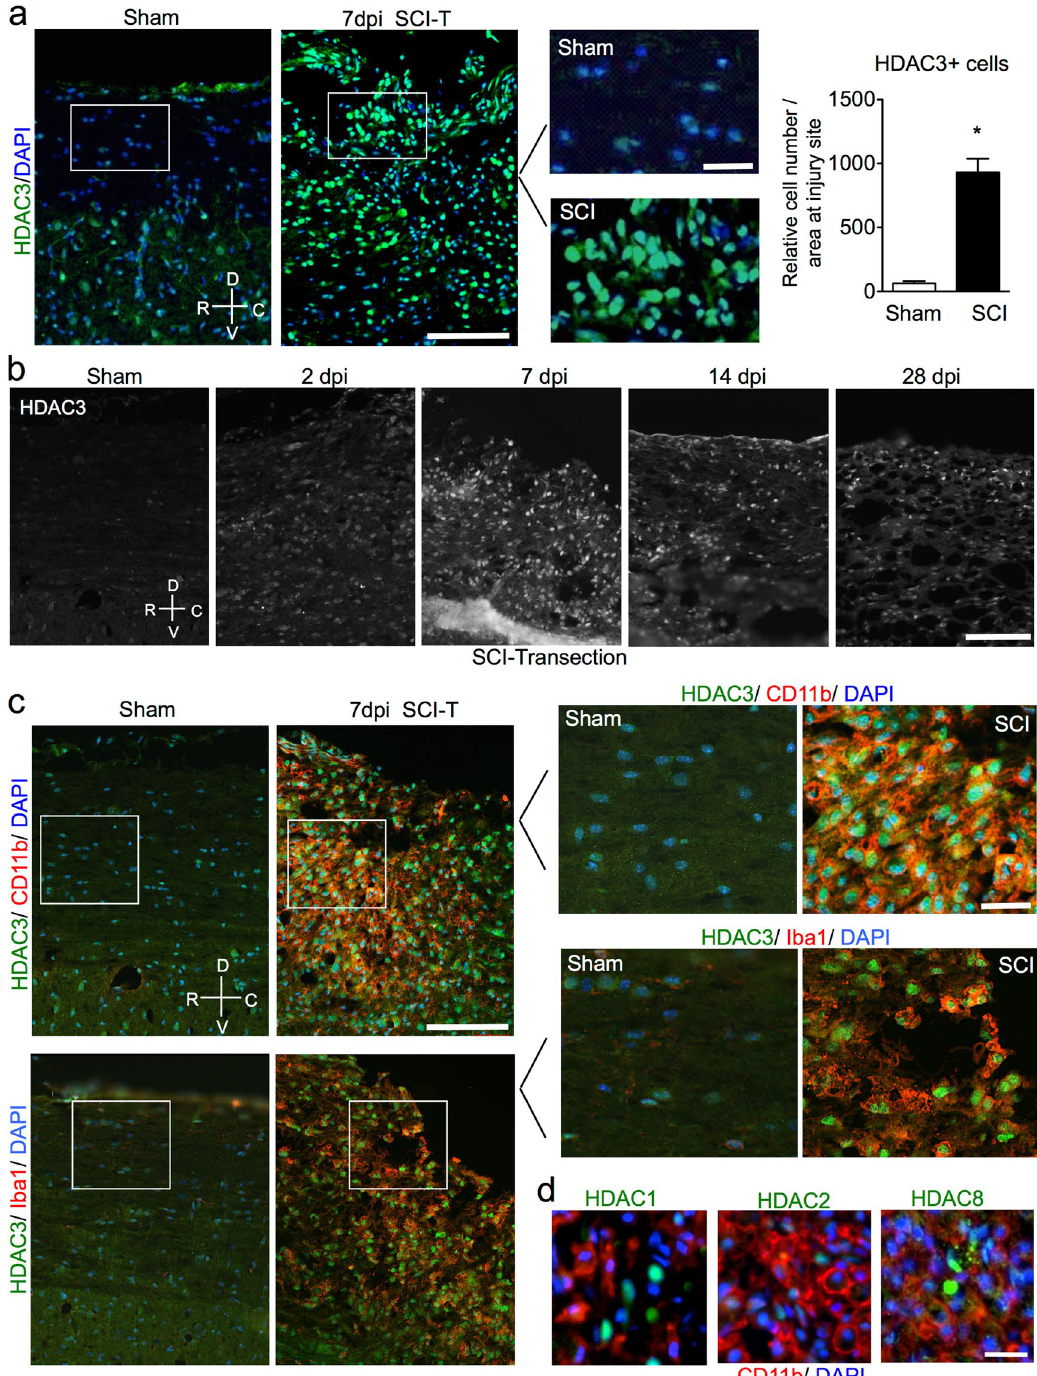
Figure 1. Upregulation of HDAC3 in microglia/macrophages after SCI. ( a ) Representative sagittal immunohistochemistry images and quantification demonstrate upregulation of HDAC3 (green) at lesion center 7 days post injury (7 dpi) by T8 dorsal column transection (SCI-T). DAPI nuclear counterstaining highlights the increased cellularity at lesion core. Enlarged images of boxed areas are shown on the right. Quantification of the number of HDAC3 + cells at the injury site is shown on the right: * p = 0.015, parametric slit-plot ANOVA. 3 pairs of mice were examined, with 3 representative images quantified for each animal. ( b ) Representative immunohistochemistry images of HDAC3 at different time points after SCI-T as compared to sham. ( c ) Representative immunofluorescent images of co-immunolabeling show a large overlap of HDAC3 + cells (green) and CD11b + or Iba1 + immune cells (red) at the injury site at 7 days after SCI-T. Enlarged images of boxed areas are shown on the right. ( d ) Immunohistochemistry images for CD11b (red) and different class I HDACs (green) at 7 days after SCI-T. No significant overlaps were detected between these HDACs and CD11b. Orientation: R: Rostral, C: Caudal, D: Dorsal, V: Ventral. Scale bars: 100 µ m ( a , b , c ), 25 µ m ( d , enlarged images in a , c